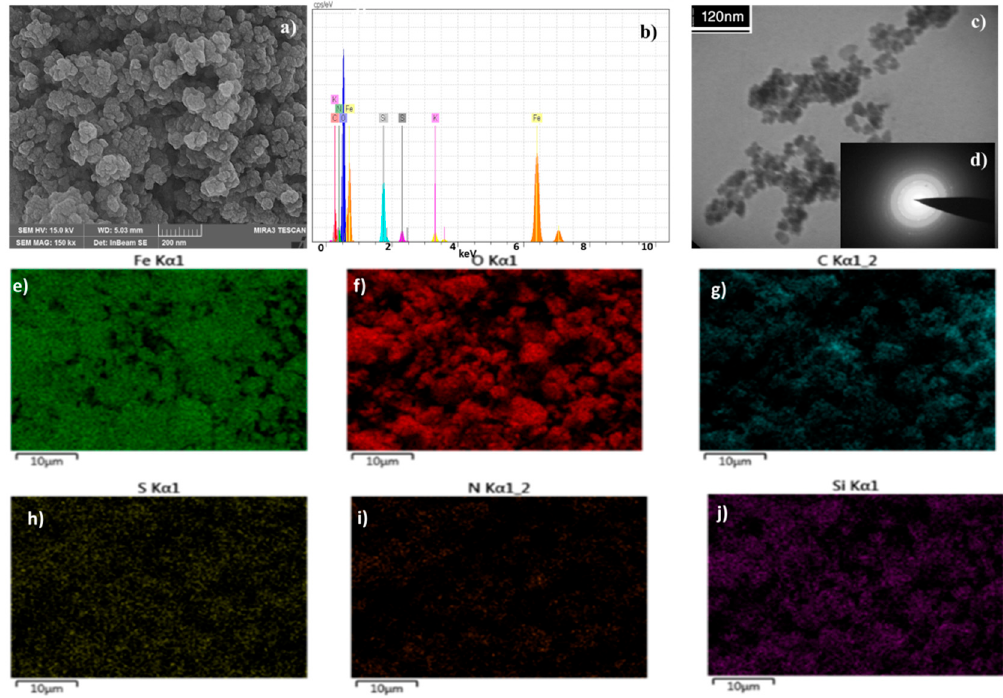
Figure 2. ( a ) SEM image, ( b ) EDS spectrum, ( c ) TEM image, and ( d ) SAED pattern of Prn/Fe 2 O 3 @SiO 2 , ( e – j ) SEM elemental mapping of Prn/Fe 2 O 3 @SiO 2